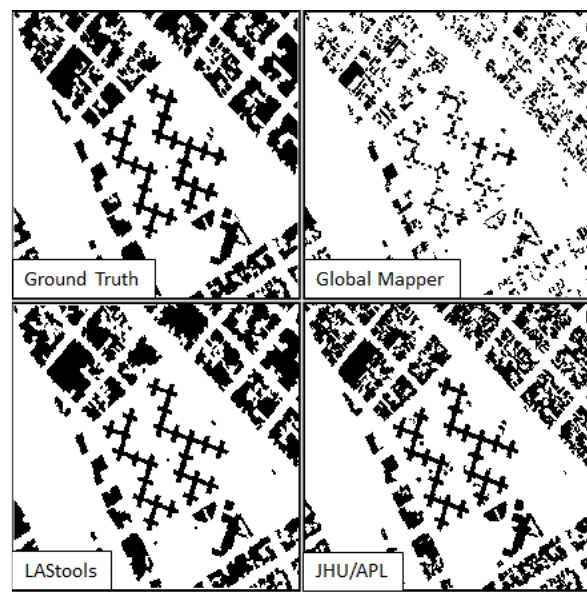
Figure 3 Automated lidar building classification results from open source JHU/APL software compare favorably to well- established methods.